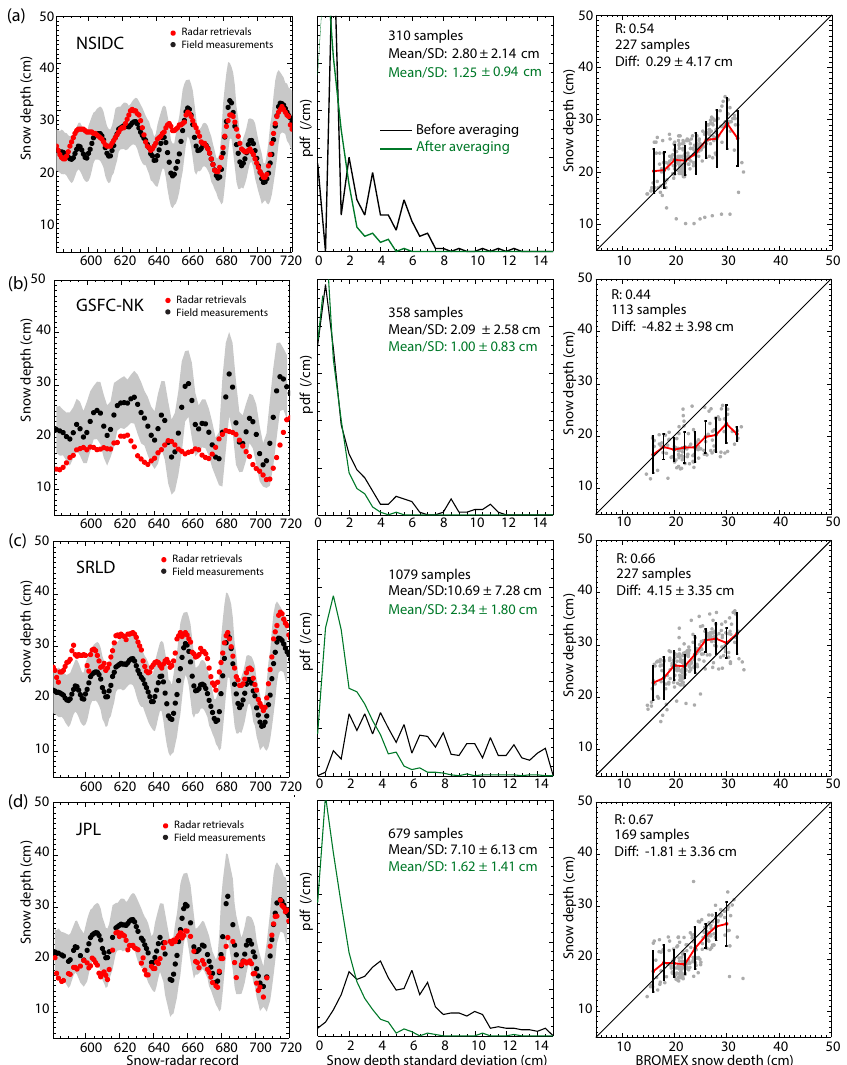
Figure 4. Comparison of four algorithms with field measurements from BROMEX: (a) NSIDC, (b) GSFC-NK, (c) SRLD, and (d) JPL. Left panel: averaged field (black dots) and retrieved (red dots) snow depths with standard deviation at each sample (gray band). Center panel: standard deviation of retrieved snow depth before (black) and after (green) averaging − 40m along track. Right panel: scatterplot shows correlation ( R ) between the averaged snow depth samples; the number of samples and the mean and standard deviation of the differences are shown on the top-left corner of plot. Error bars show standard deviation of samples in 2cm bins.